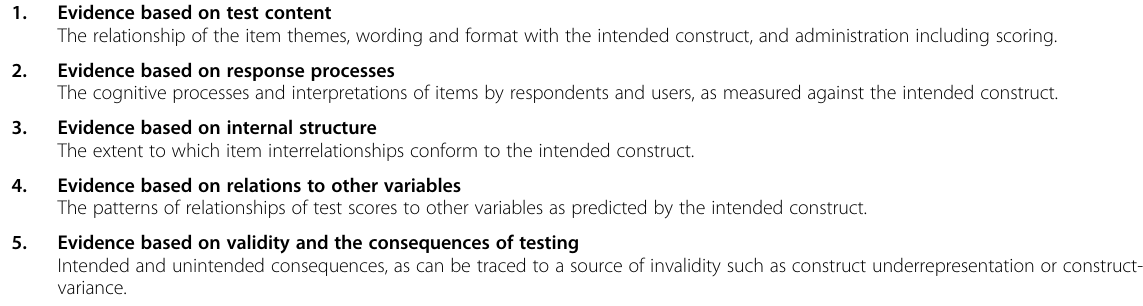
Table 1 The five sources of validity evidence [7, 49]